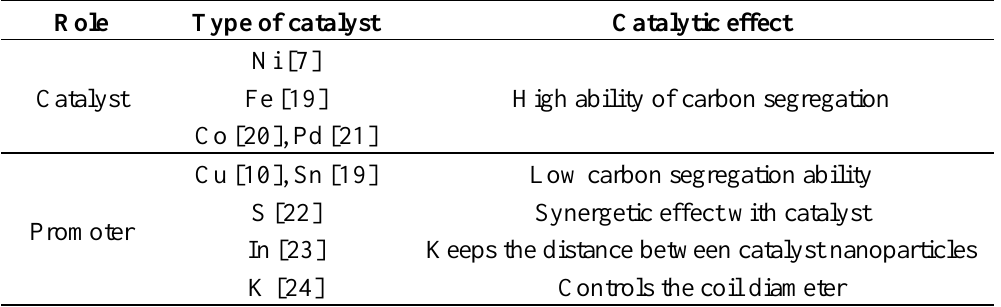
Table 1. Classification of catalysts for carbon nanotubes (CNTs) and CNCs